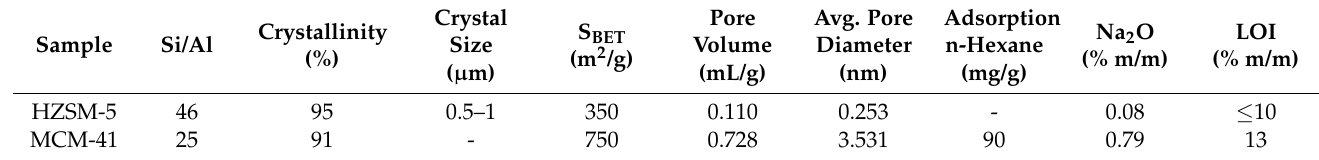
Table 2. Properties of the